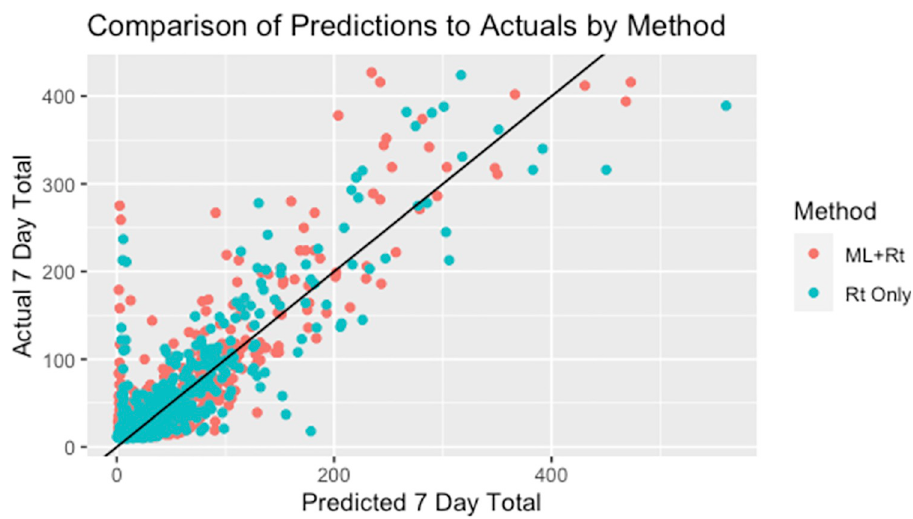
Fig 4. A comparison of actual 7-day case totals and predicted 7-day cases totals for the ML+R t methods.